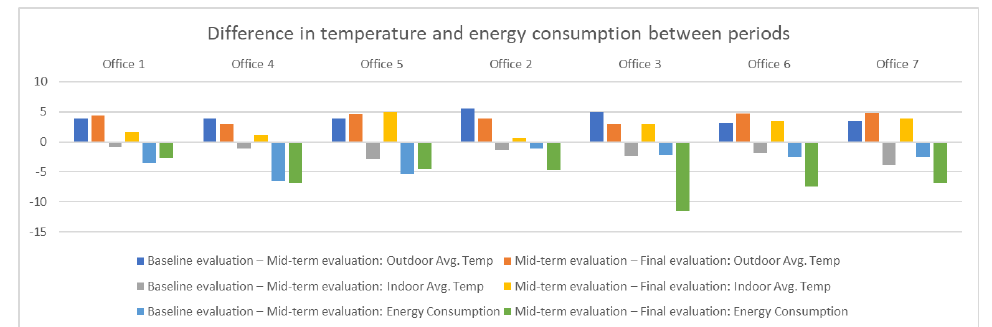
Figure 15. Representation of the difference between the temperature and the energy consumption between periods.